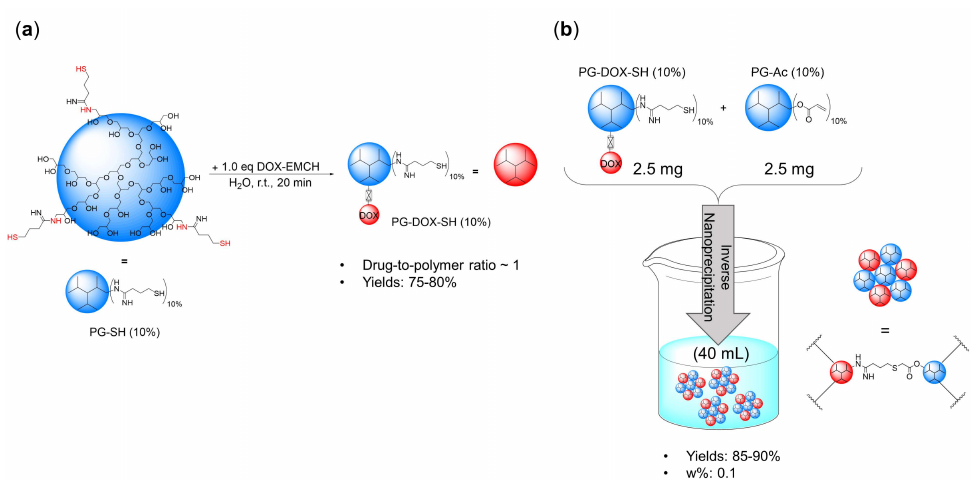
Figure 3. ( a ) Preparation of PG-DOX-SH conjugate and ( b ) PG-DOX NG via inverse